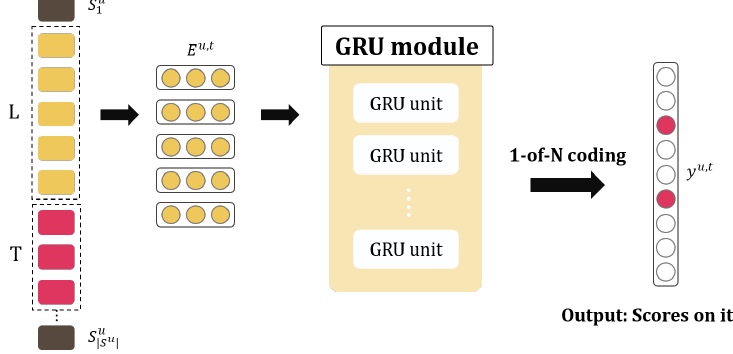
Figure 2. Model architecture of gated recurrent units for recommendation (GRU4Rec)